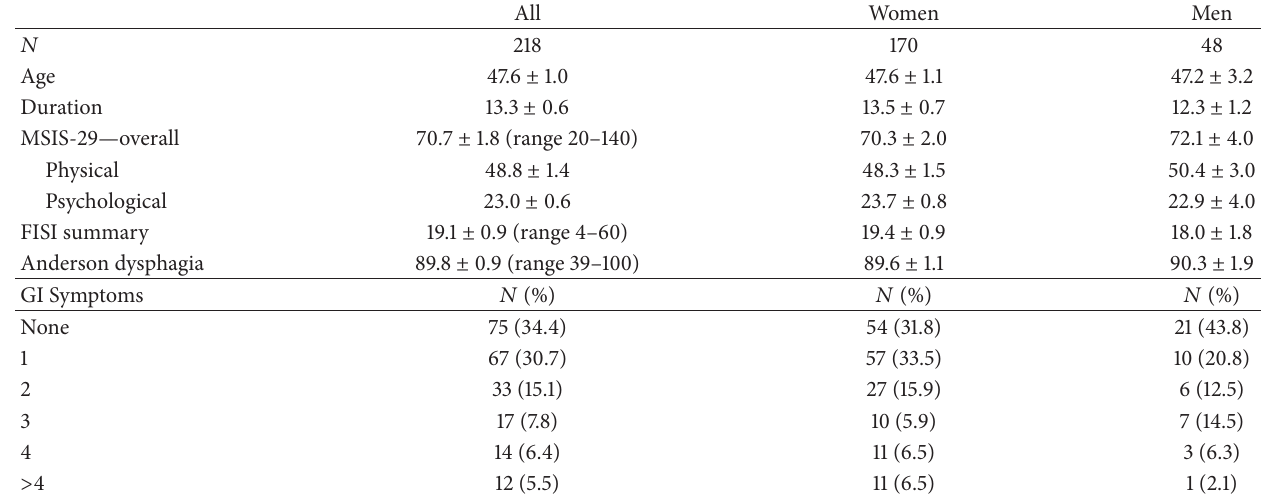
Table 1: Demographic and clinical characteristics of the study MS population.